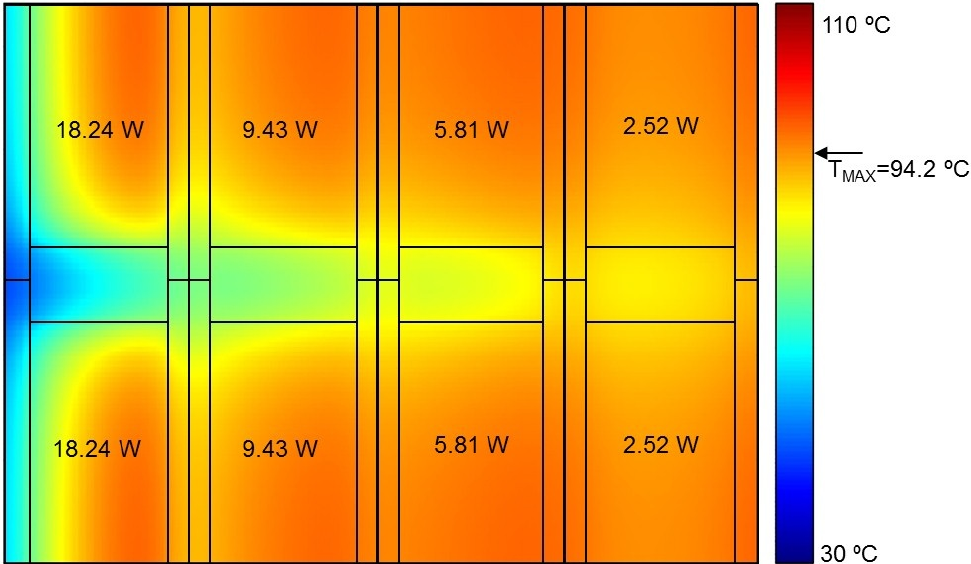
Figure 11. Temperature map of the middle layer of the simulated 3D processor where the power dissipated in cores was found by running Monte Carlo simulations (the optimal solution). The power dissipated in other processor units is listed in Table 2. The inlets are located on the left side of the chip.